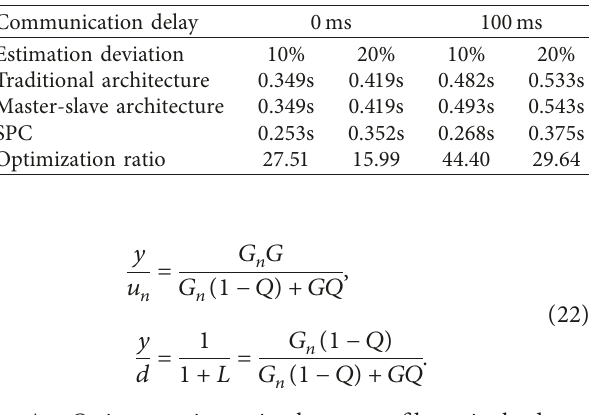
Table 1: The optimization of the minimum string-stable time headway under different estimation accuracy.